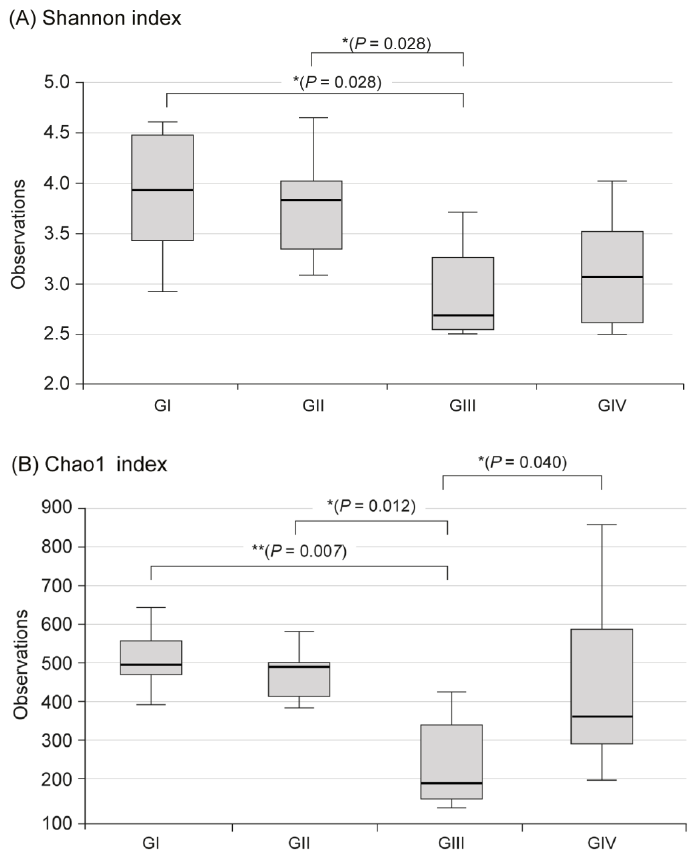
Figure 1. Alpha diversity in fecal microbiome between four groups. ( A ) Shannon index, ( B ) Chao index, Group I, normal group consisting of uninfected mice; group II to IV, infected mice with H. pylori ; group II, a negative control group, received distilled water as a vehicle; group III, a positive control group, treated with the standard triple therapy consisting of amoxicillin (14.25 mg / kg), clarithromycin (14.3 mg / kg), and omeprazole (138 mg / kg); group IV, treated with amoxicillin (14.25 mg / kg), gentamicin-intercalated smectite hybrid which emitted 8 mg / kg of gentamicin, and omeprazole (138 mg / kg). Shannon index, information about community composition and richness; Cho1 index, estimate diversity from abundance